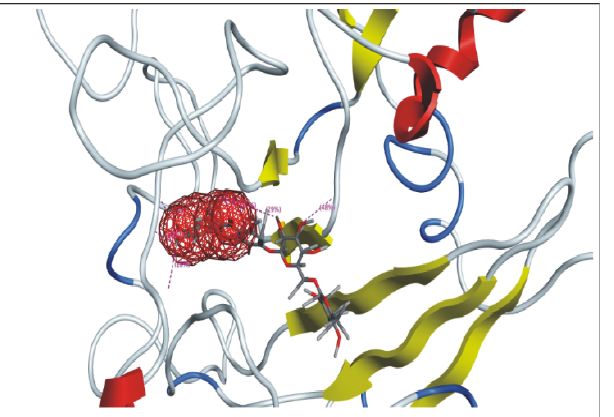
Figure 6. Three ‐ dimensional view of V protein docking with interacting region of querce ‐ Figure 6. Three-dimensional view of V protein docking with interacting region of quercetin-7-O-[ α - tin ‐ 7 ‐ O ‐ [ α‐ L ‐ rhamnopyranosyl(1 → 6) ‐β‐ D ‐ galactopyranoside]. The values of 29% and 48% show L-rhamnopyranosyl(1 → 6)- β -D-galactopyranoside]. The values of 29% and 48% show the binding the binding strengths of hydrogen atoms of flavonoids. strengths of hydrogen atoms of